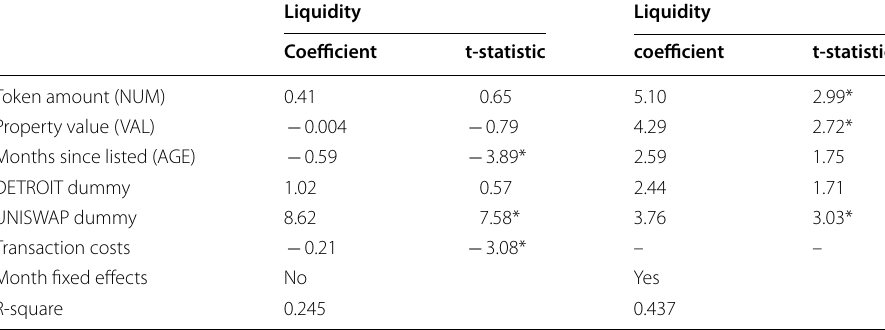
Statistical significance at the 5% level indicated with a